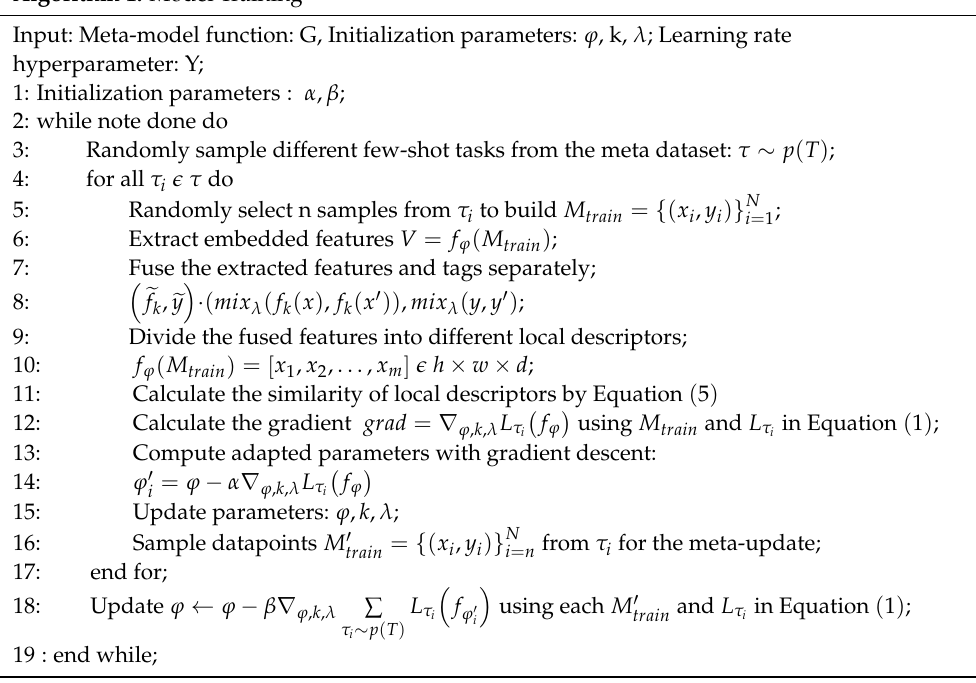
Algorithm 1. Model